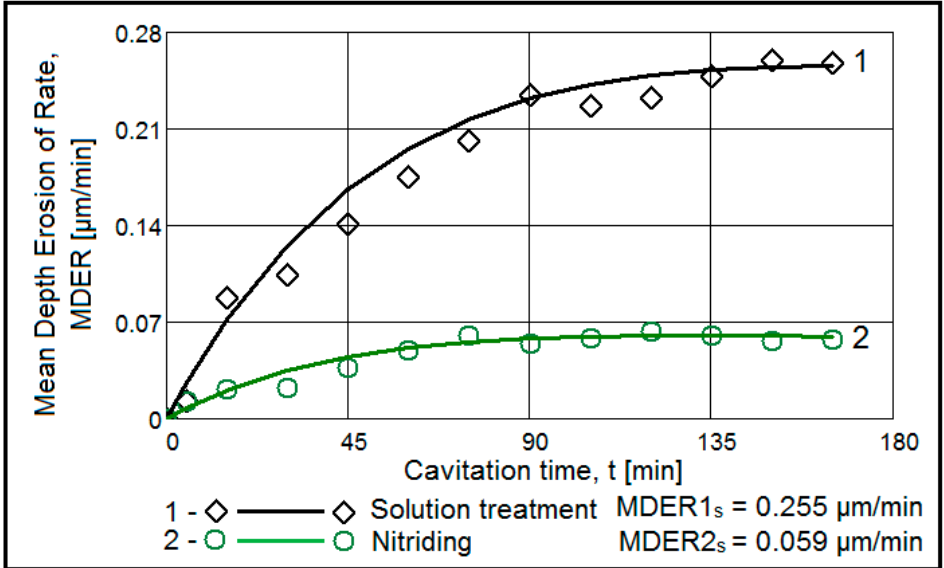
Figure 3. The evolution of mean depth of erosion rate with the cavitation time (1—solution treatment; 2—solution treatment + nitriding).